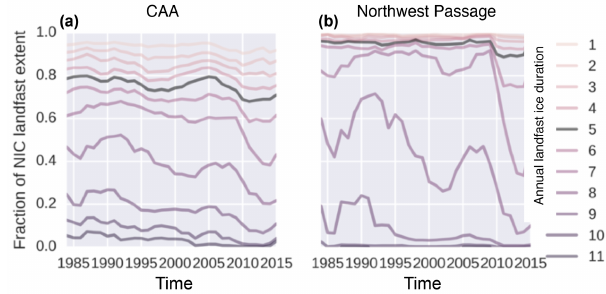
Figure 6. (a) Time series (5-year running-mean) of the fraction of NIC landfast ice extent over the CAA (magenta line in Fig. 2b) cov- ered by landfast ice from CIS ice charts for more than the number of months indicated by the line colour. (b) Same as (a) but over the Northwest